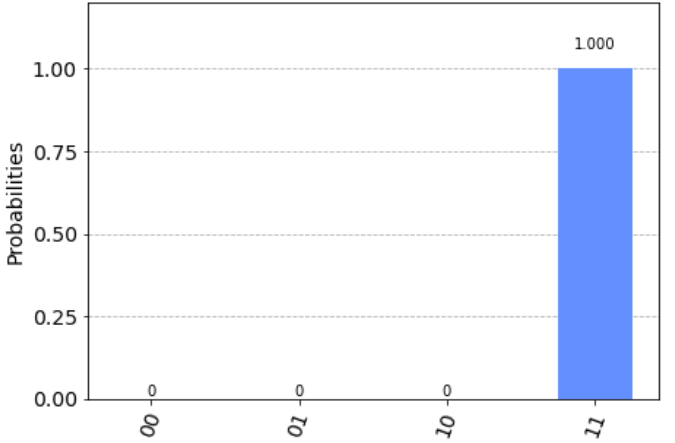
Figure 11. The results of the Grover algorithm for the two-variable Boolean equations.